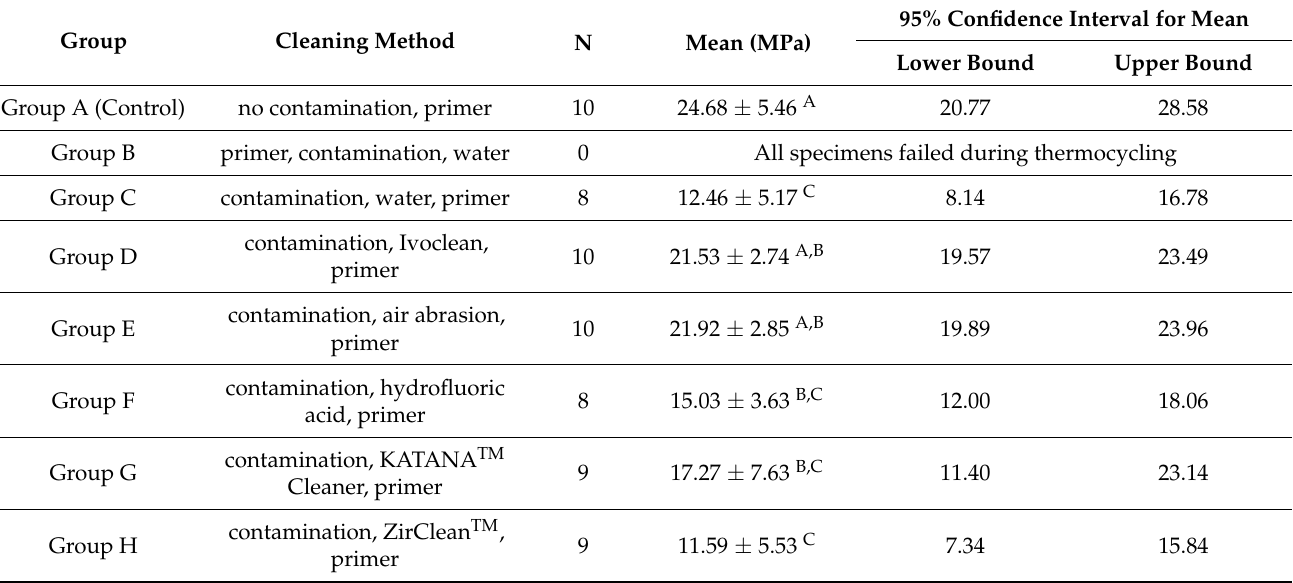
Table 2. Descriptive statistics for shear bond strength